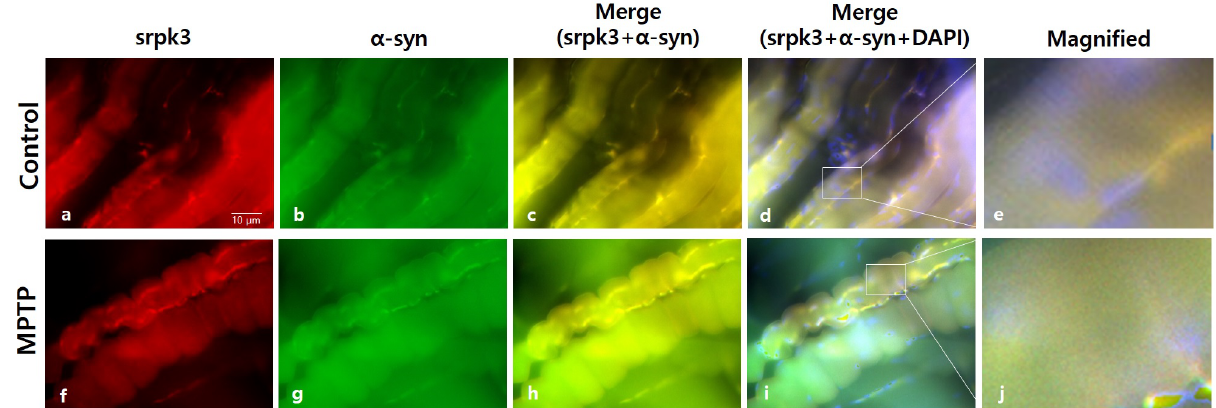
Figure 4. Immunofluorescence staining of serine/arginine-rich protein specific kinase 3 ( srpk3 ) and α -synuclein ( α -syn) in the quadriceps femoris of an MPTP-induced parkinsonism mouse model. Control group: ( a ) srpk3; ( b ) α -syn; ( c ) merging of ( a , b ); ( d ) merging of ( a , b ), and DAPI (nuclei); ( e ) magnified image of the square. MPTP group: ( f ) srpk3; ( g ) α -syn; ( h ) merging of ( f , g ); ( i ) merging of ( f , g ), and DAPI; ( j ) magnified image of the square (scale bar, 10 µm).